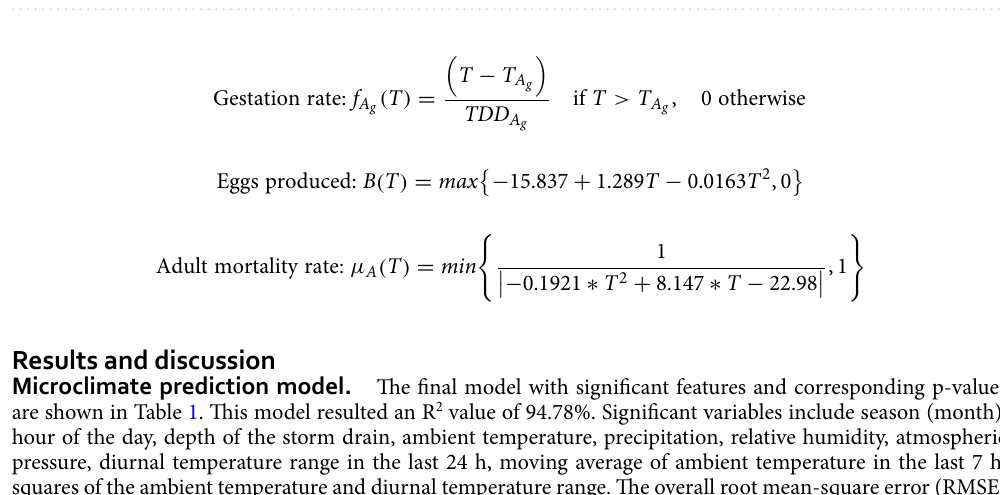
Figure 8. (Left) time sequenced actual versus predicted values for U40; (Right) actual vs predicted values of all the